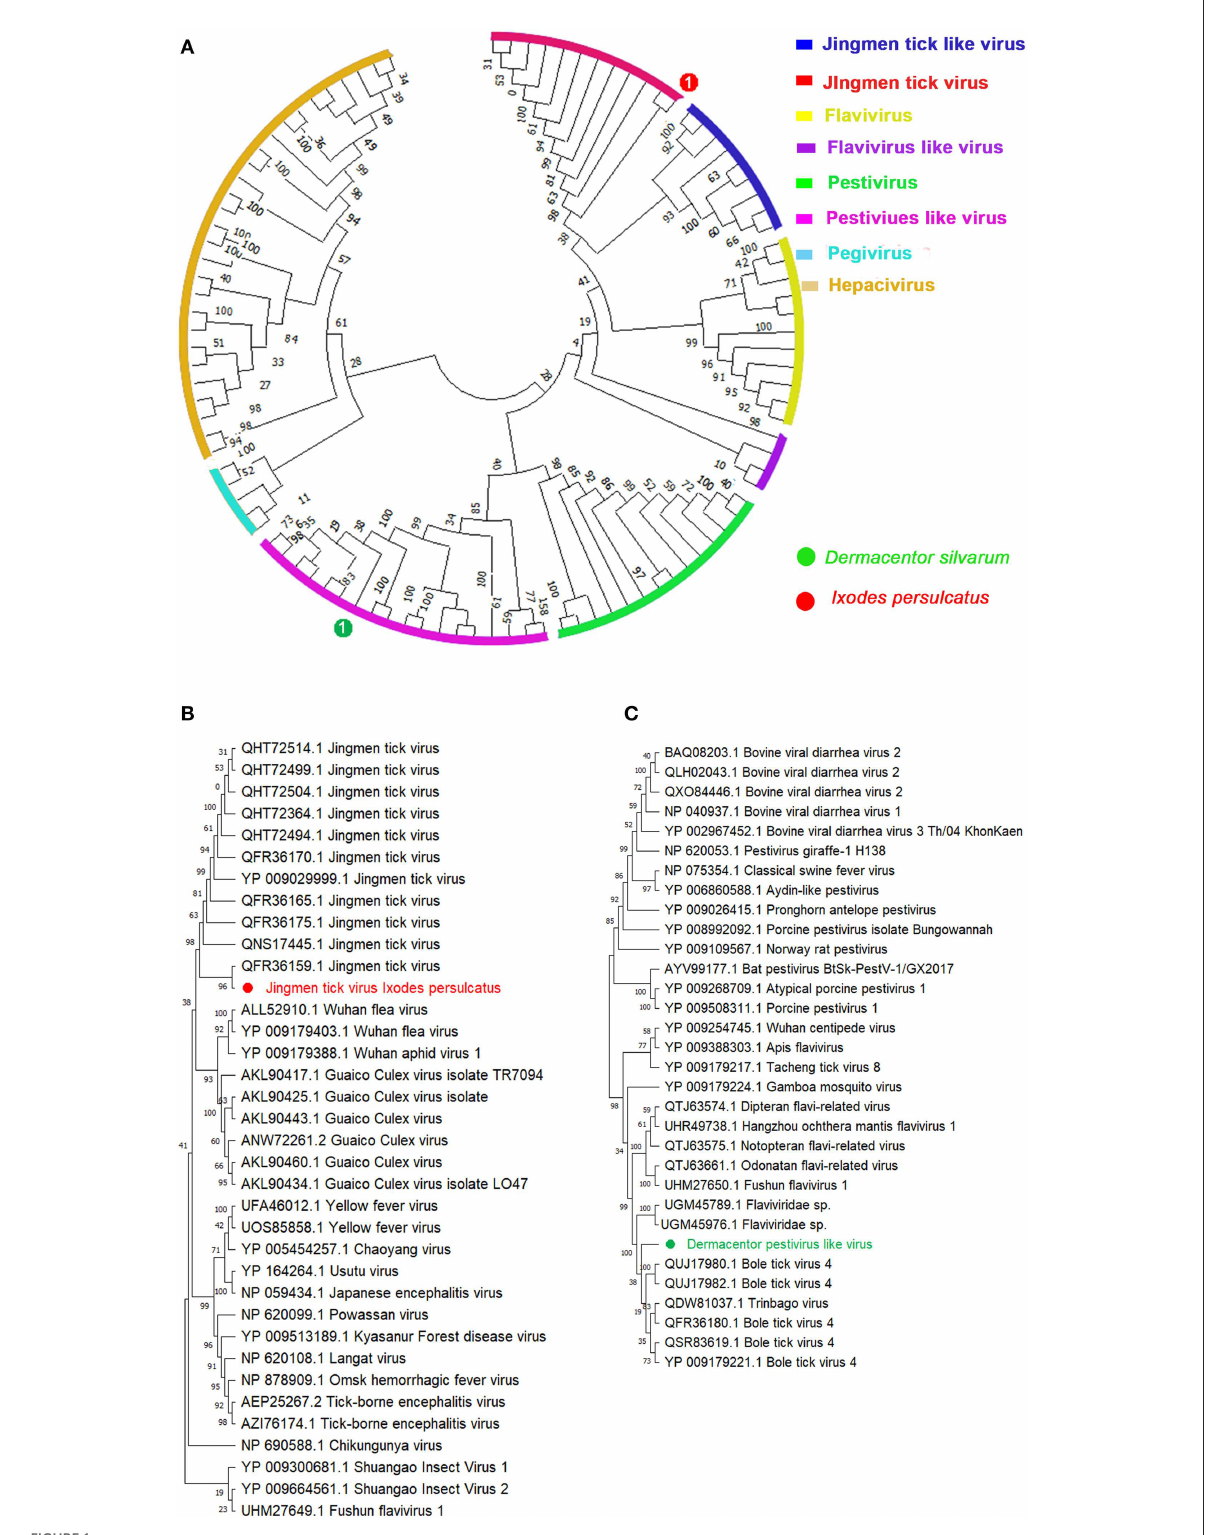
FIGURE1 Phylogenetic analysis of representative branches in the family Flaviviridae based on the RdRp sequences. (A) Enhanced region showing the relationship of the unclassified Pestivirus -like group in relation to Pestivirus and Flavivirus. (B) Enhanced region showing the relationship